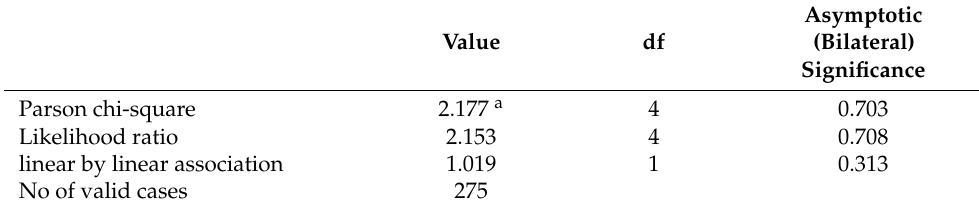
Table 14. Chi-square tests: remote work and time of